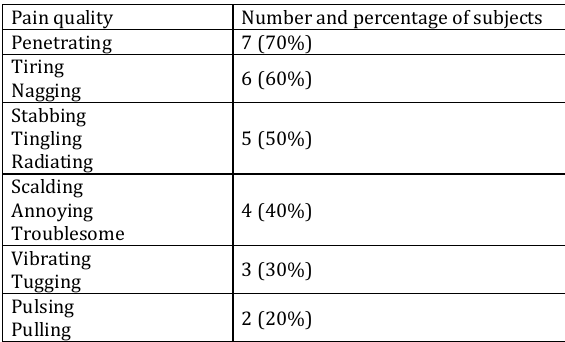
Table 3. The most frequent word descriptors chosen to characterise phantom pain (N = 10; multiple choice was possible)